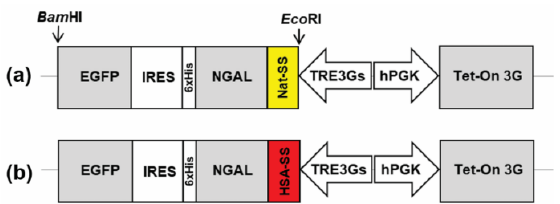
Figure 1. Schematic diagram of the bicistronic Tet-On inducible vector for NGAL and EGFP ex- pression. The NGAL-6xHis tagged and EGFP genes were linked in tandem with IRES. The pLVX- TetOne-Puro vector was used as the acceptor vector. ( a ) The native signal sequence (Nat-SS) and ( b ) the human serum albumin signal sequence (HSA-SS) were separately inserted into the upstream of the NGAL gene, resulting in two plasmids named pLVX-Tet-On-Nat/NGAL and pLVX-Tet-On-HSA/NGAL, respectively.